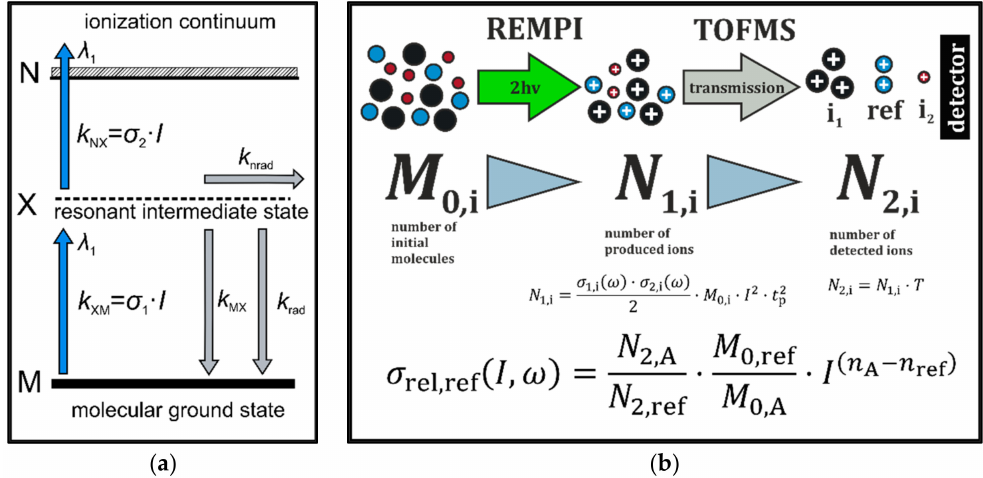
Figure 1. ( a ) Ionization scheme of (1 + 1) one-color resonance enhanced multiphoton